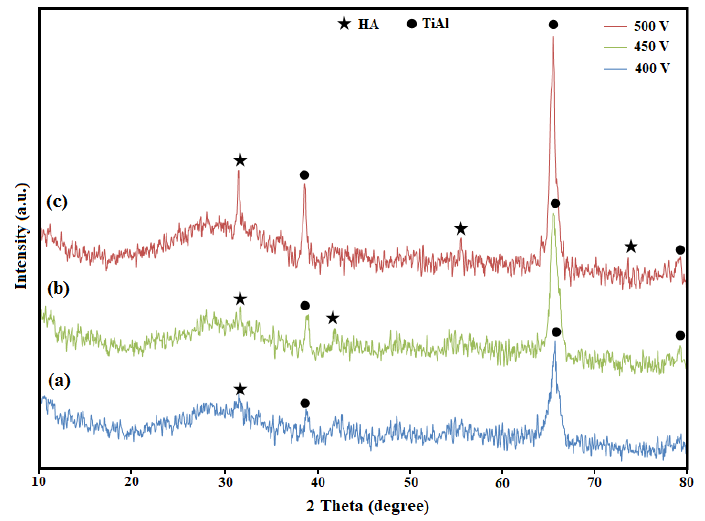
Figure 6. X-ray diffraction patterns of PEO coatings prepared under applied voltages of ( a ) 400 V, ( b ) 450 V, and ( c ) 500 V after immersion in SBF for 28 days.